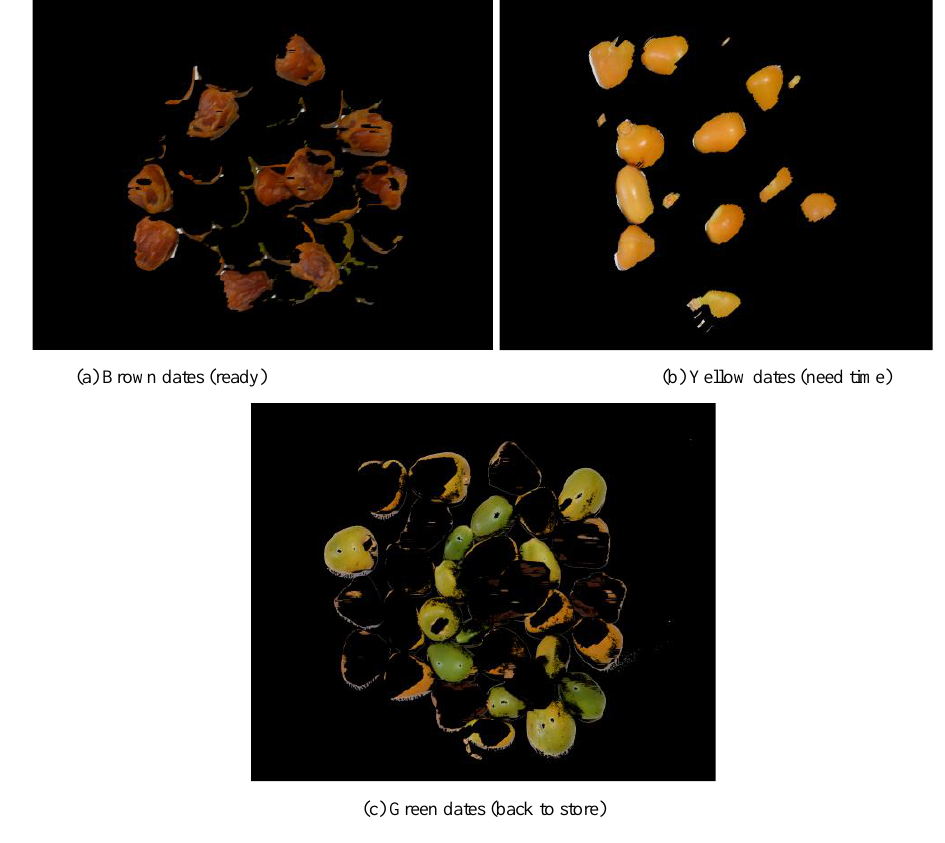
Figure 8. Classification images with their ripened period Table 3. Percentage of graded